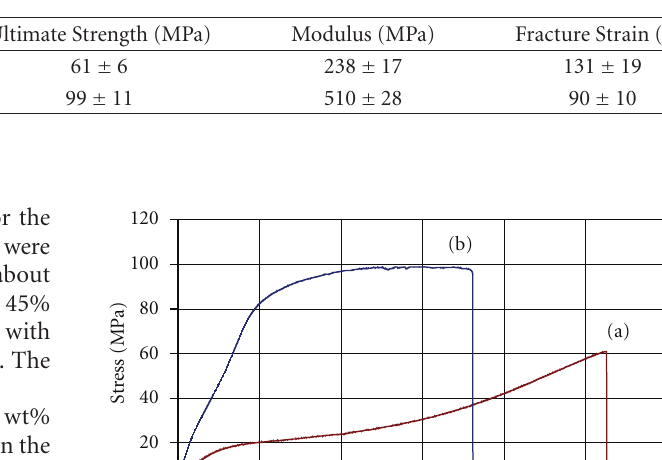
Table 1: Tensile Test Data.